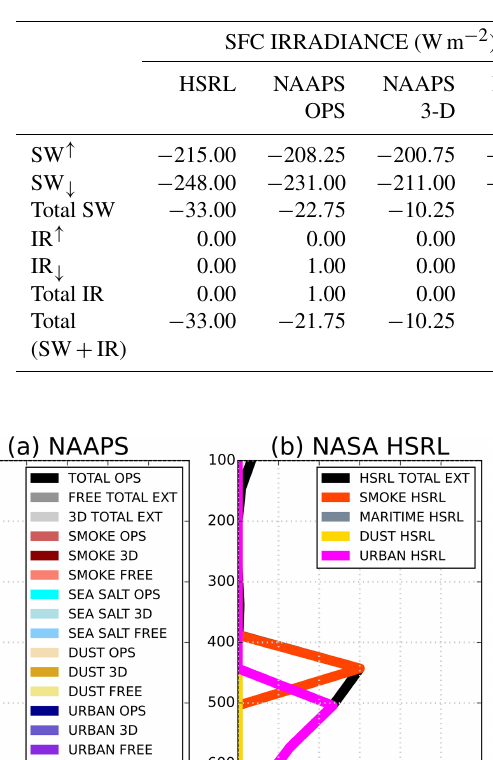
Table 2. Instantaneous radiative forcing results at the surface and top–of-atmosphere (TOA) for the Thunder Basin case study, utilizing the MAIAC 555nm reflectances.